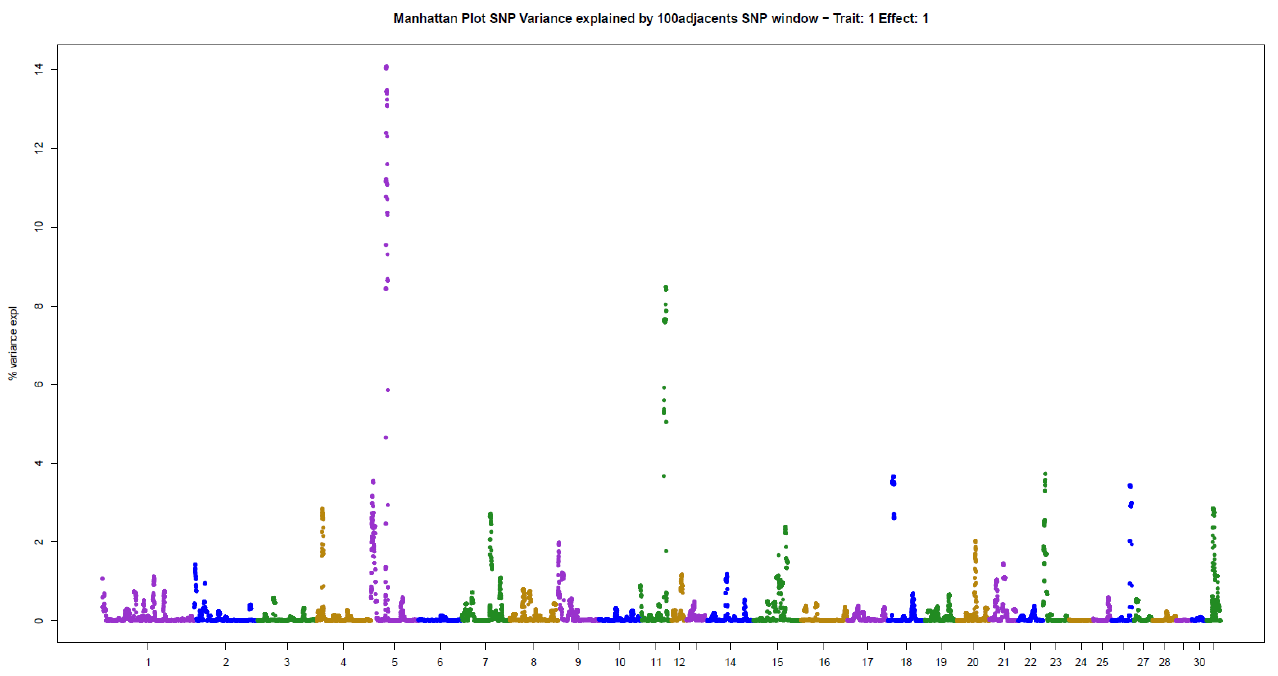
Figure 3. Manhattan plot of hair whorl number on the head of Quarter Horses. The y-axis indi- cates the proportion of variance explained by windows of 100 adjacent SNPs. The chromosomes are given on the x-axis.